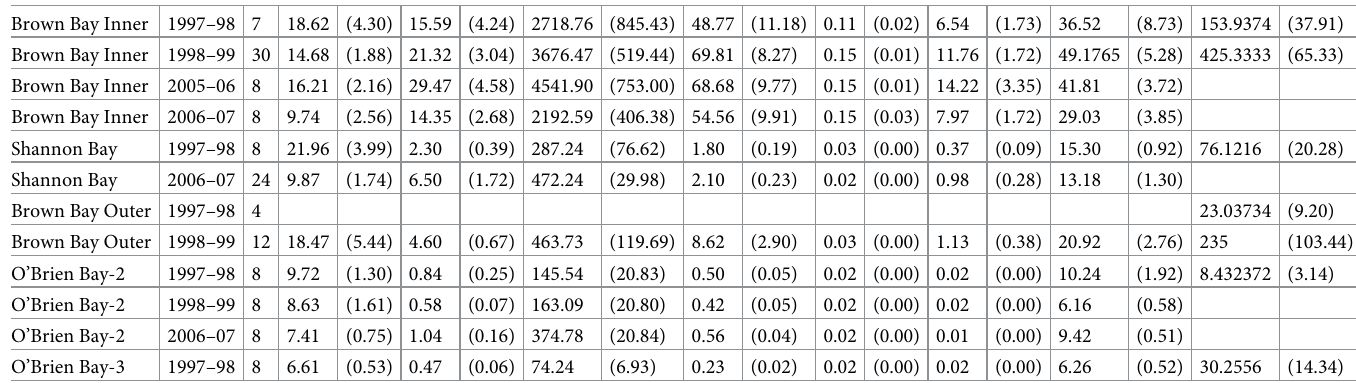
Table 1. Metal and total petroleum hydrocarbon (TPH) levels in marine sediments at each site. Standard error (SE) in brackets, n = number of